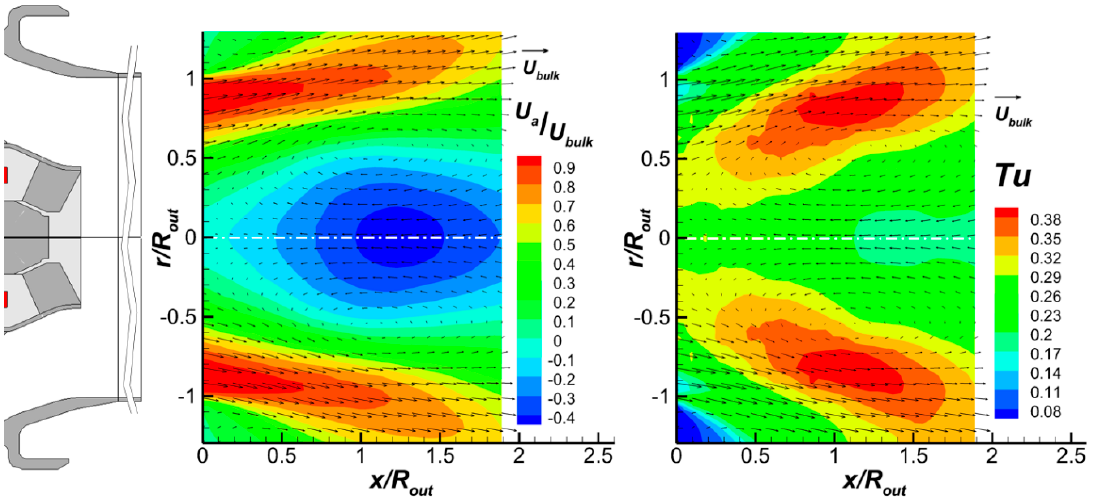
Figure 4. PIV measurements in a meridional plane: Contour plots of the axial velocity component ( left ) and of the turbulence intensity ( right ) with the superposed velocity vector field.